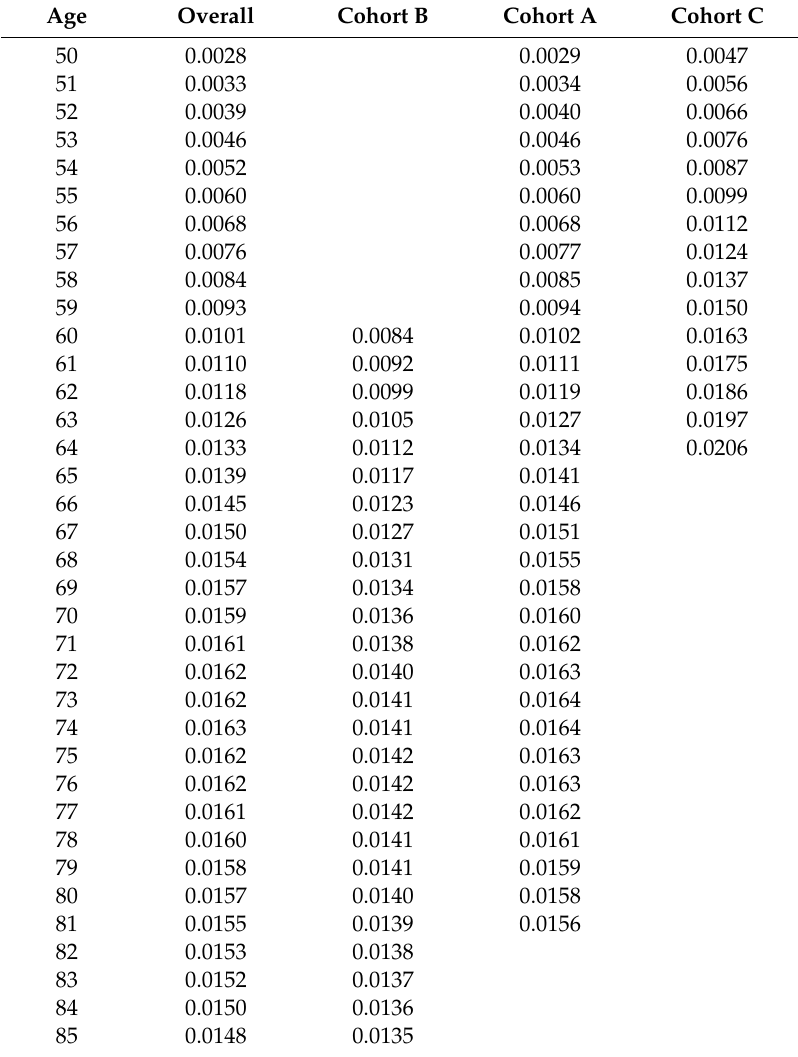
Table 4. Probability of diabetes mellitus morbidity at the age of